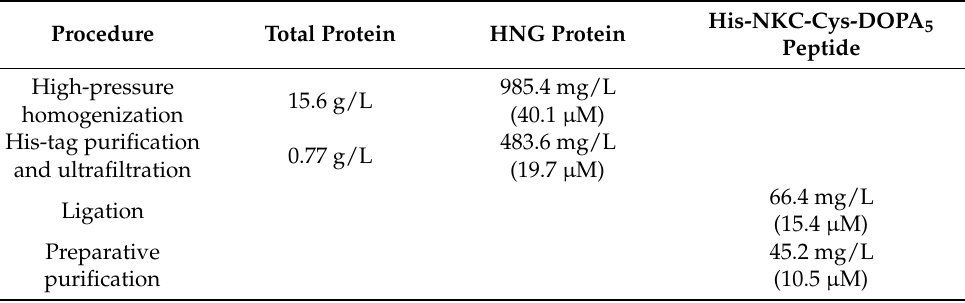
Table 2. Protein yields during the reaction